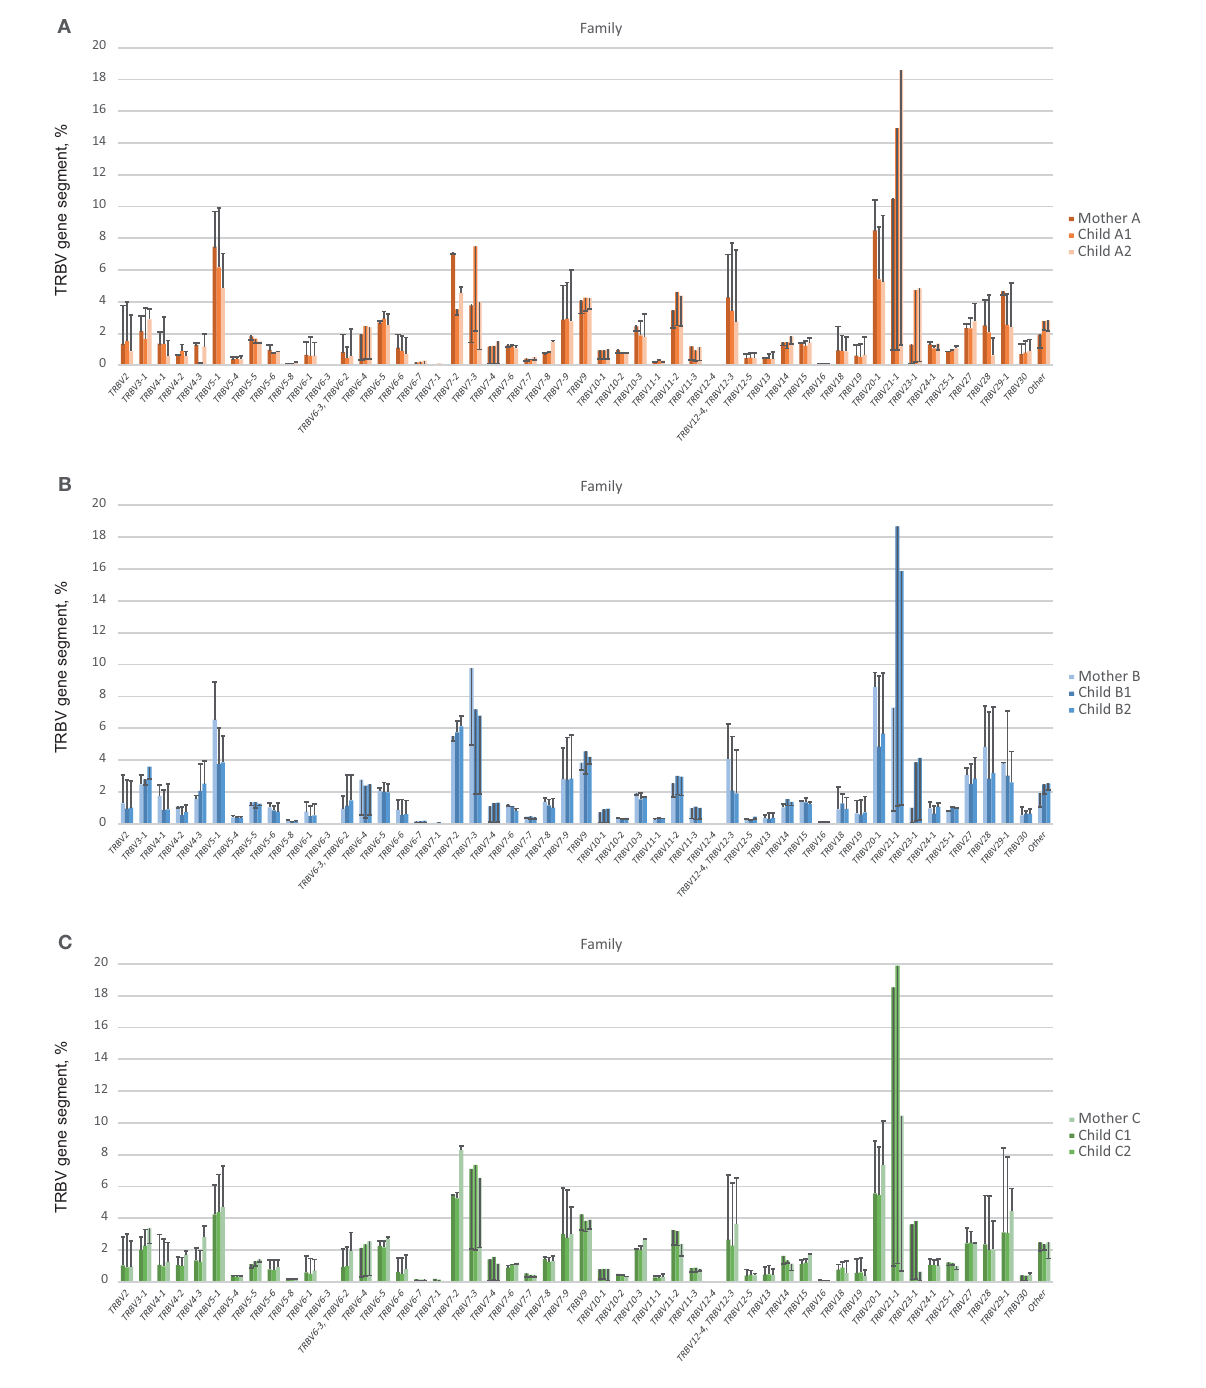
FIGURE 4 |TRBV gene segment usage in functional low-frequencyTCR beta clonotypes in comparison to out-of-frameTCR variants . Colored bars indicate the representation of a particularTRBV gene segment family in out-of-frameTCR variants from each individual. Lines represent alterations in